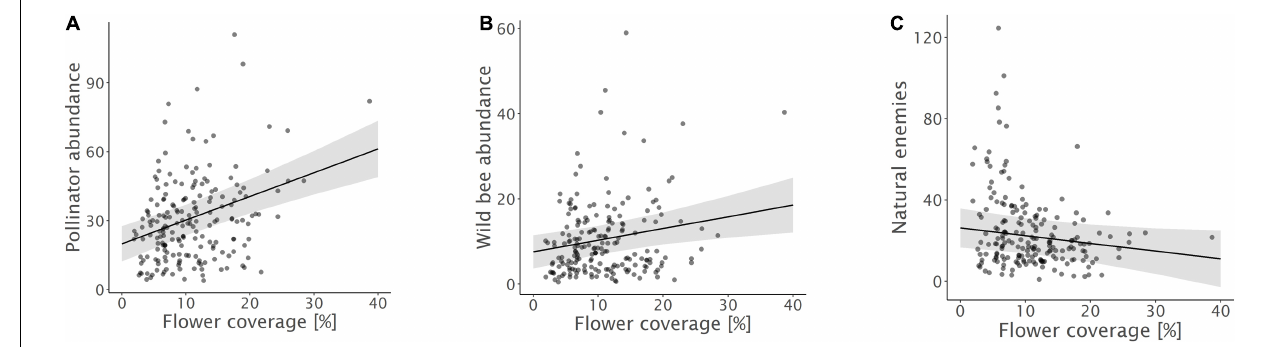
FIGURE 4 | Relationships between (A) pollinator abundance, (B) wild bee abundance, and (C) natural enemy abundance and flower coverage. Model predictions with 95% confidence intervals and raw data points are shown.